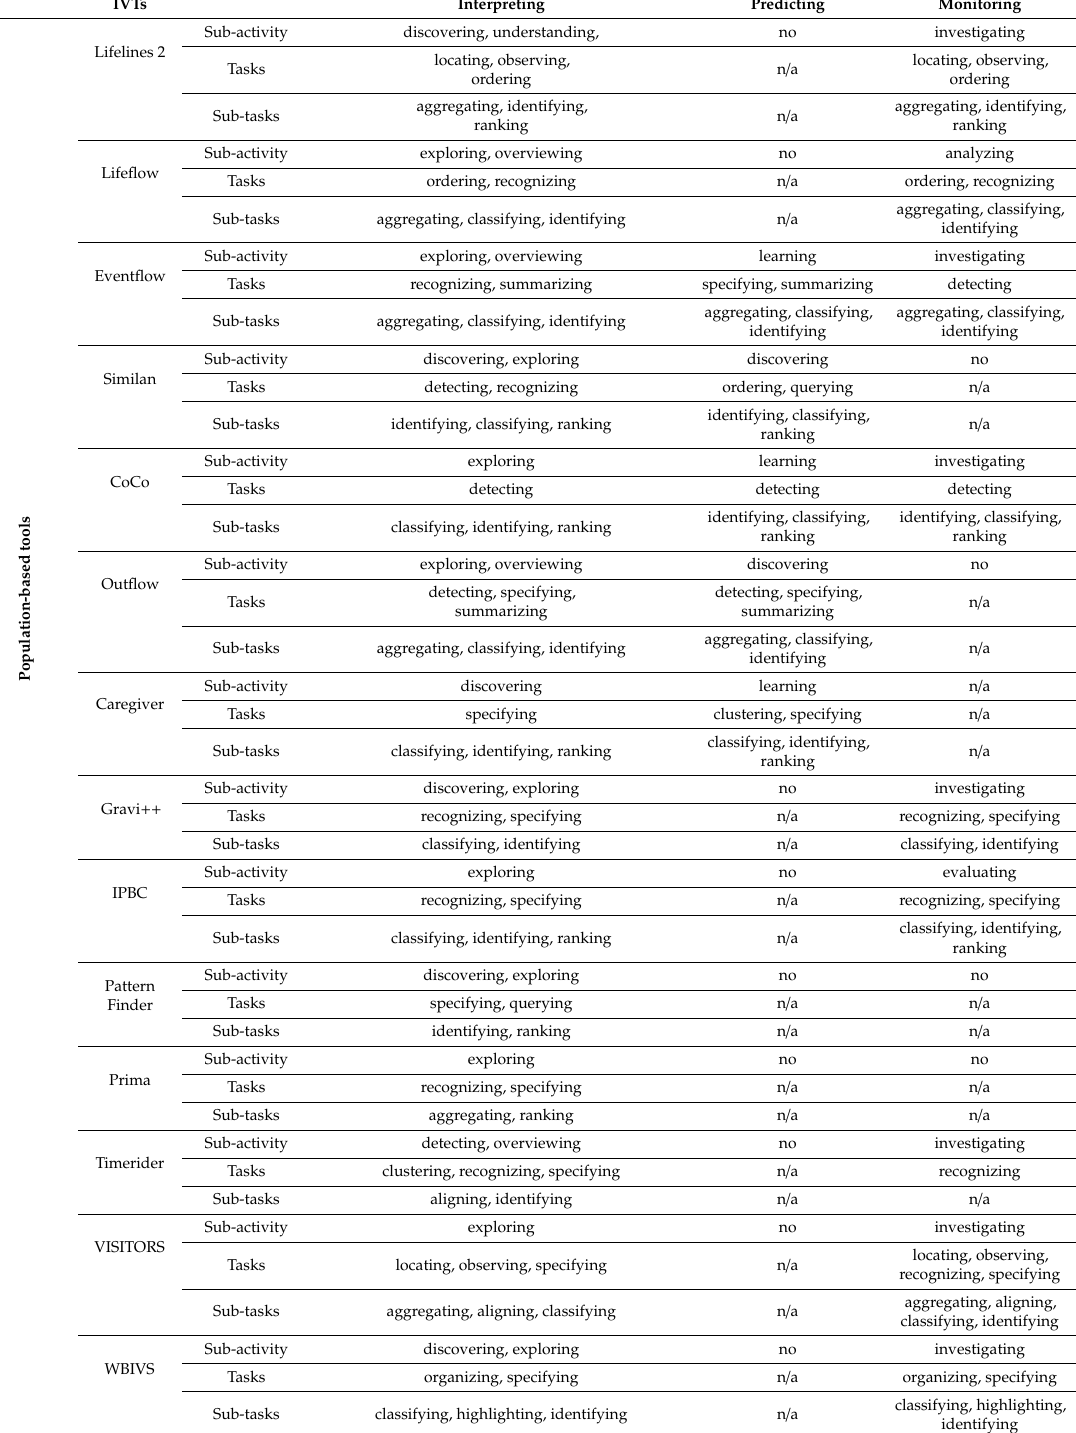
Table 3. Evaluation summary of the 19 existing tools based on the proposed